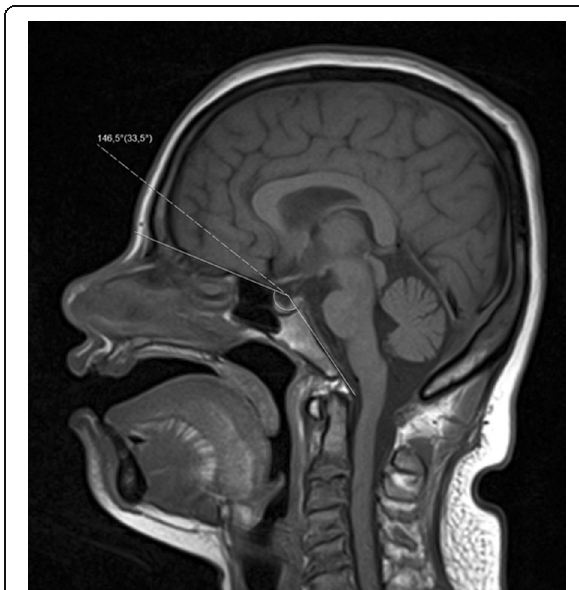
Fig. 4 Sagittal T1/SE of a 38-year-old Down syndrome patient with platybasia (skull base angle >143°). As shown in the figure, this angle is measured using a line joining the nasion with the center of the pituitary fossa and a line joining the anterior border of the foramen magnum and the center of the pituitary